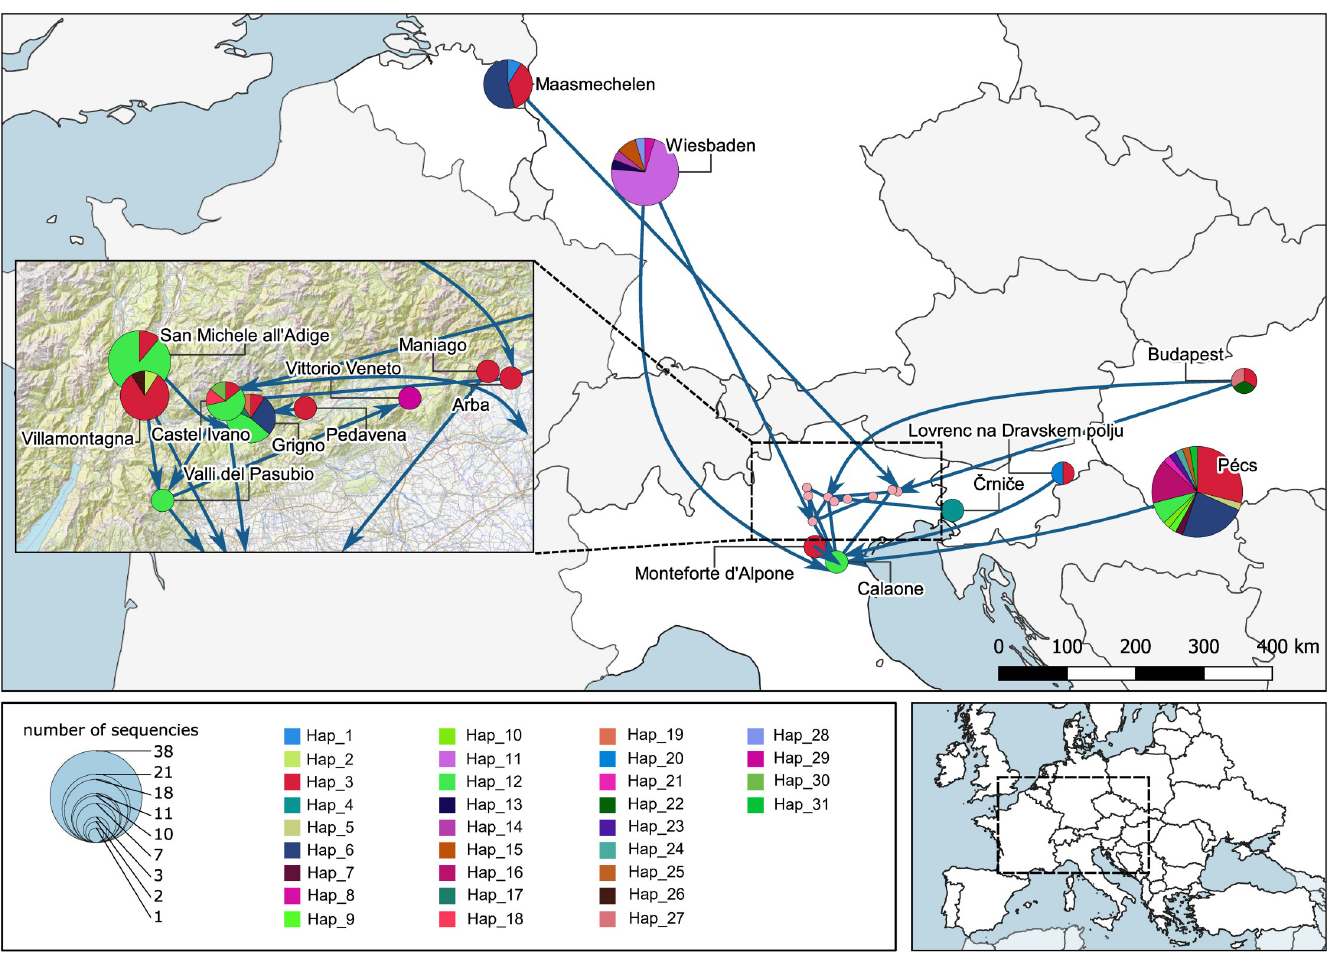
Fig 2. Phylogeography of Aedes koreicus based on COI haplotypes in Europe. The geographical placement of pie charts (colored by haplotype distribution) on the map corresponds to the locations where mosquitoes were collected, and the circle sizes correlate with the number of sequences obtained at each location (for more details about the locations see S1 Table). Arrows indicate the potentially most important dispersal routes with significant statistical support (S3 Appendix). (Map source: © OpenStreetMap, openstreetmap.org: OpenStreetMap contributors, the graphical display may be used under the terms of CC BY 4.0